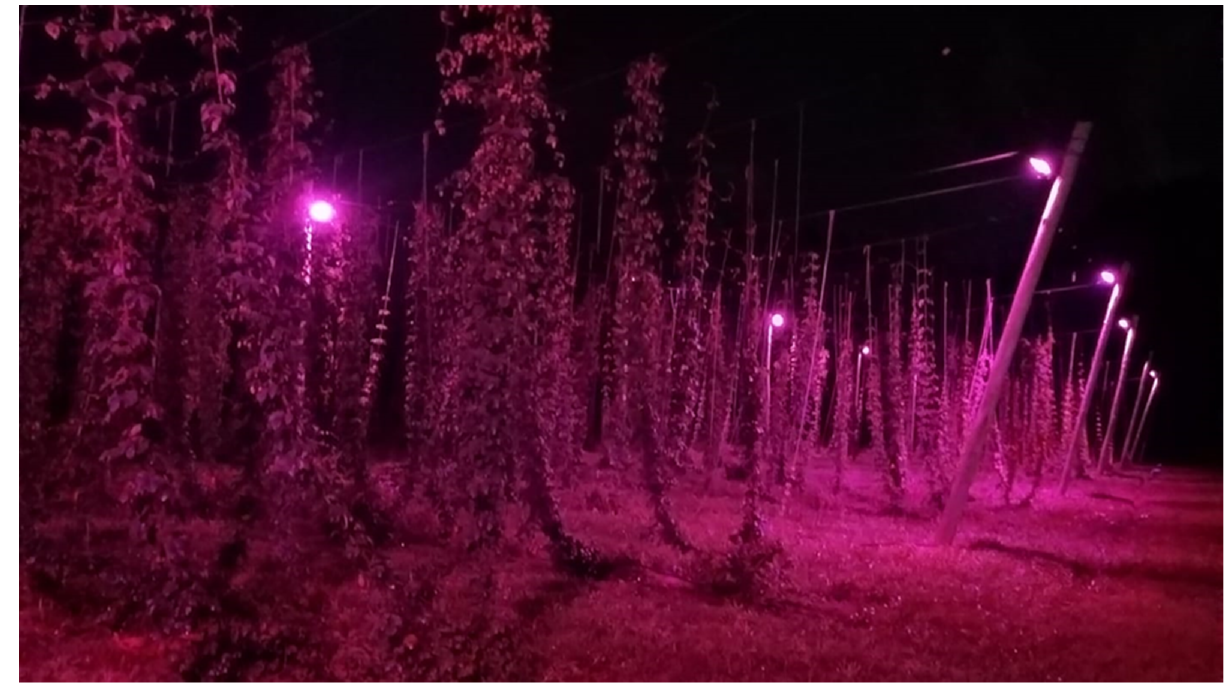
Figure 9. Supplemental lighting with LED lamps to control flowering in a hopyard in Lages, Santa Catarina state, southern Brazil.